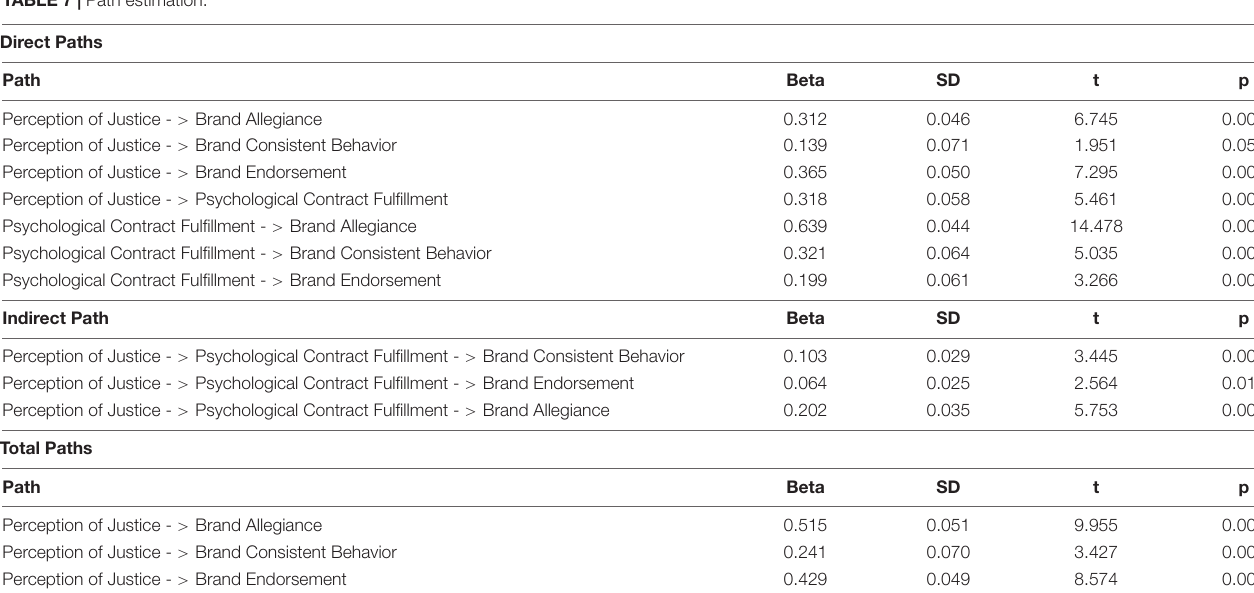
FIGURE 3 | Path estimates. TABLE 7 | Path